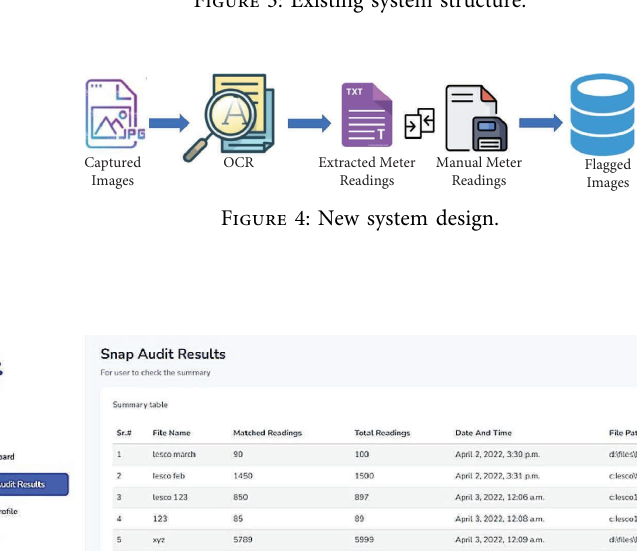
Figure 3: Existing system